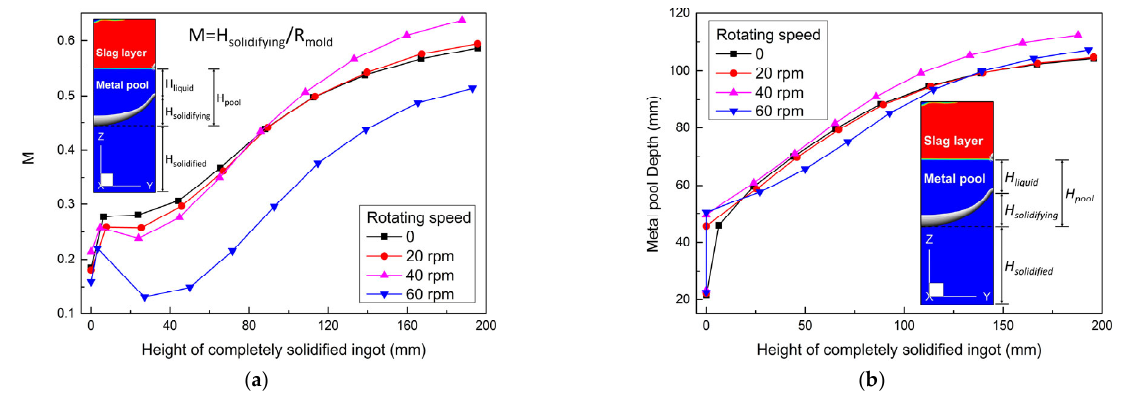
Figure 8. Evolution of metal pool profile with the electrode rotating at different speeds: ( a ) M; ( b ) metal pool depth.